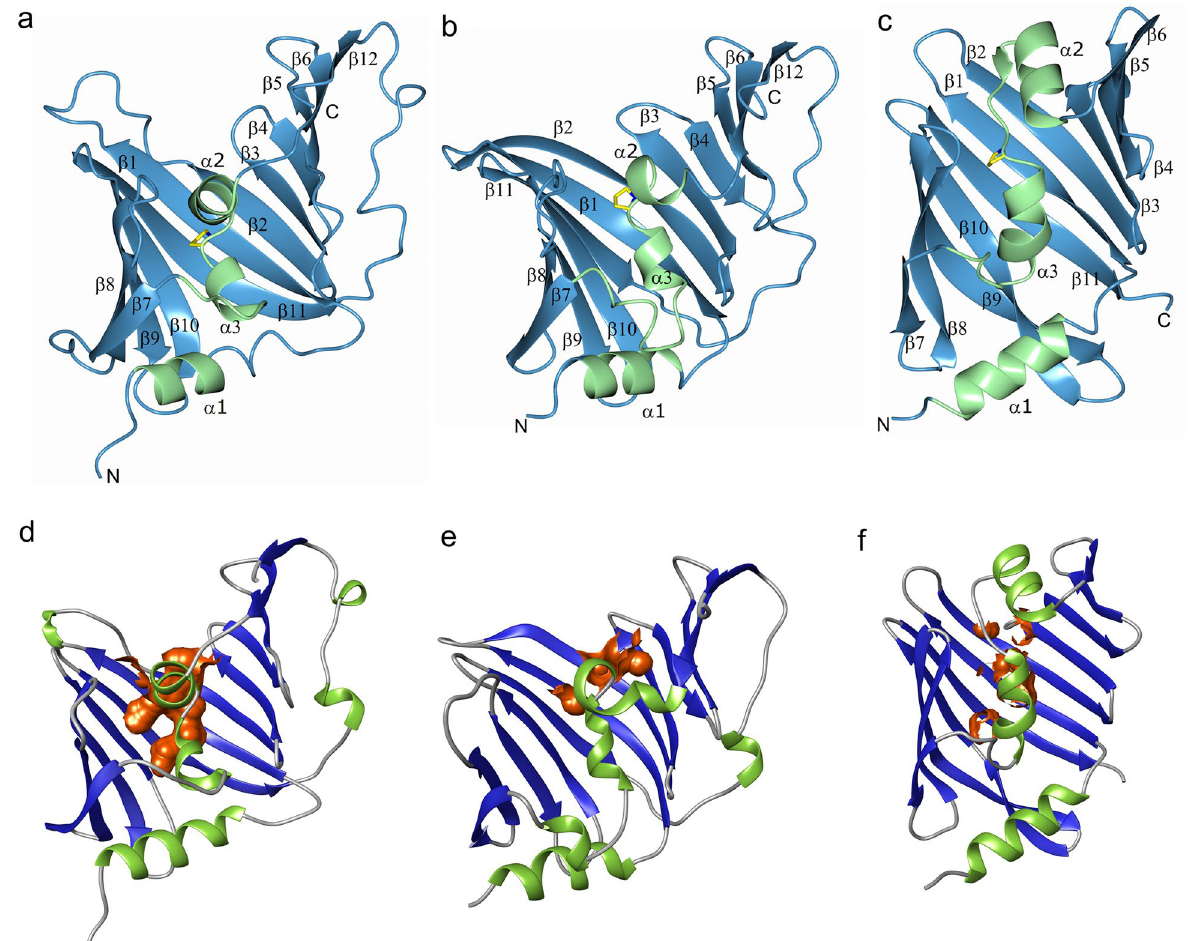
Figure 2. The overall structures of LolA and LolB. ( a ) LolA from P. gingivalis (LolA-PG), ( b ) LolA (LolA-VC) and ( c ) LolB from V. cholerae (LolB-VC). The LolA-PG and LolA-VC structures (ribbon drawings) fold as a 12 β-strand open barrel with three α-helices. LolB-VC comprises an 11 stranded open β-barrel with three helices. A conserved proline located between helix α2 and α3 is shown as a stick model in all three proteins. The β-strands and loops are depicted in blue and the helices in green. ( d–f ) The solvent accessible part of the binding clefts were calculated with CASTp 48 and are illustrated in orange. The cleft in LolA-PG is the most accessible with a volume of 36 Å 3 . The clefts of LolA-VC and LolB-VC are more scattered and comprise 0.15 and 11 Å 3